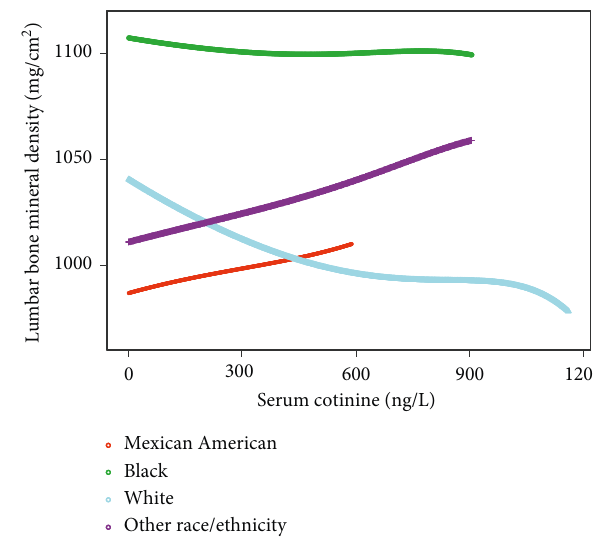
Figure 3: The association between serum cotinine and lumbar bone mineral density stratified by race/ethnicity. Age, gender, education, body mass index, physical activity, serum albumin, blood urea nitrogen, serum uric acid, serum calcium, and serum phosphorus were